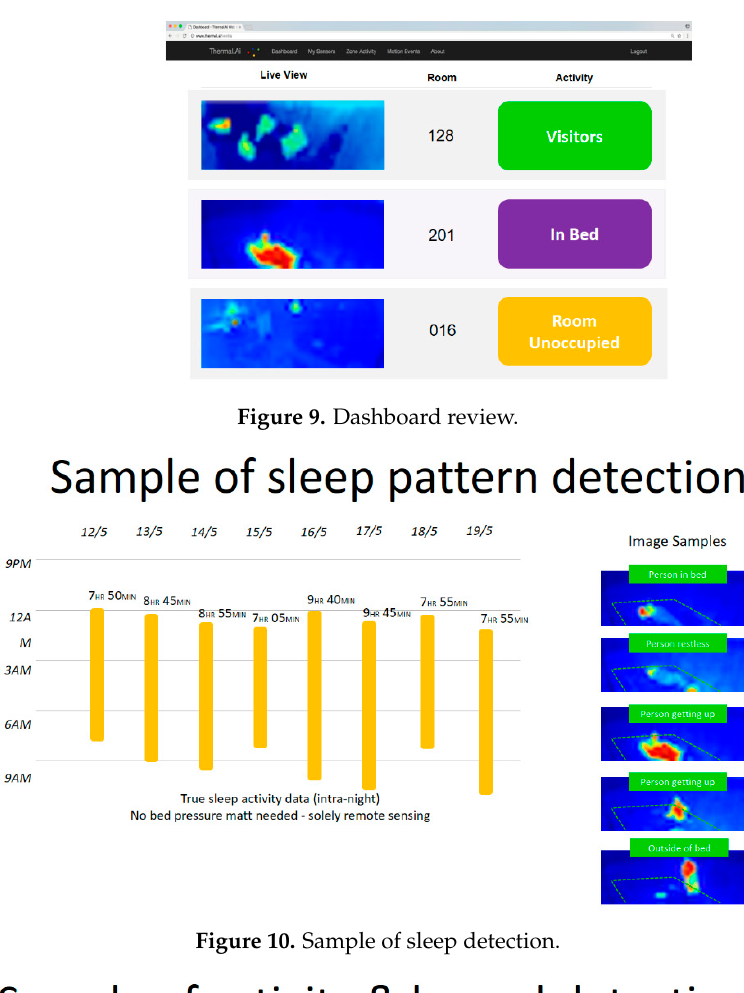
Figure 10. Sample of sleep detection.